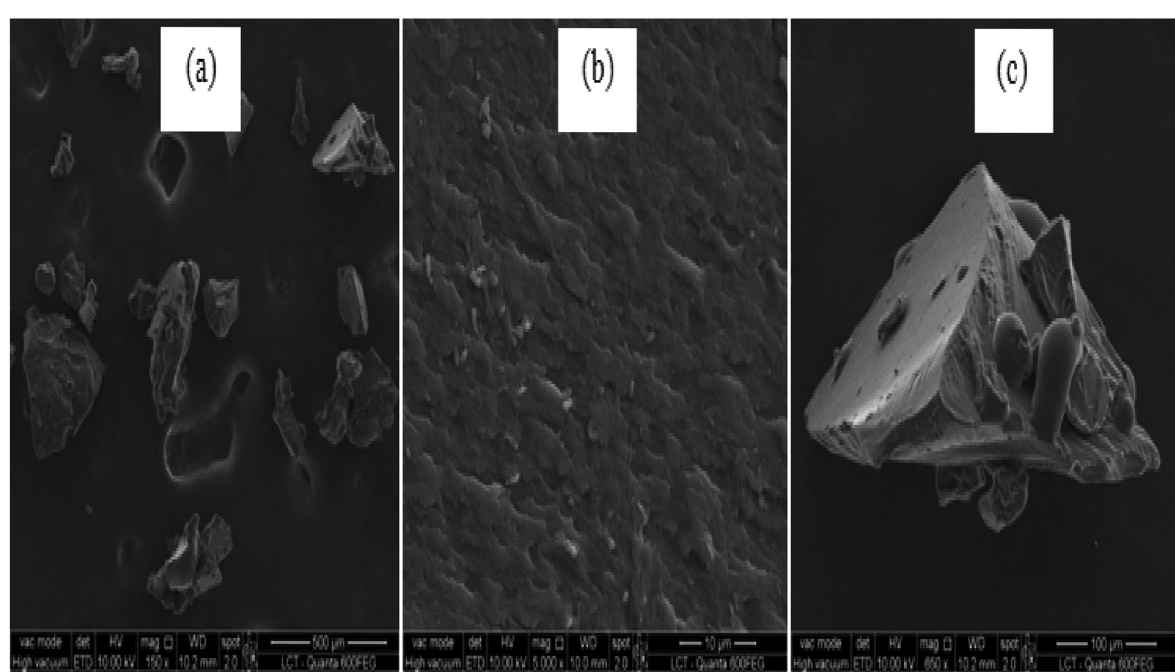
FIGURE 1 - SEM photomicrographs of gelatin (raw material) at a magnification of 150x (a), 5,000 x (b) and 650x (c).